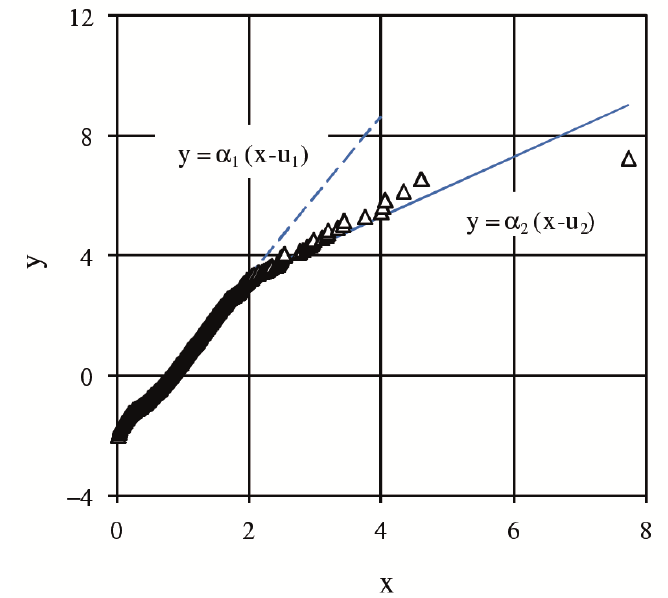
Figure 11. Gumbel’s plot for the sequence of annual maximum soil losses ( x = A e / µ ( A e ), y = − ln ln(1/ F ( x )) is the normalized Gumbel’s variable, α i and u i are the two parameters of Gumbel’s distribution, modified from [44]).